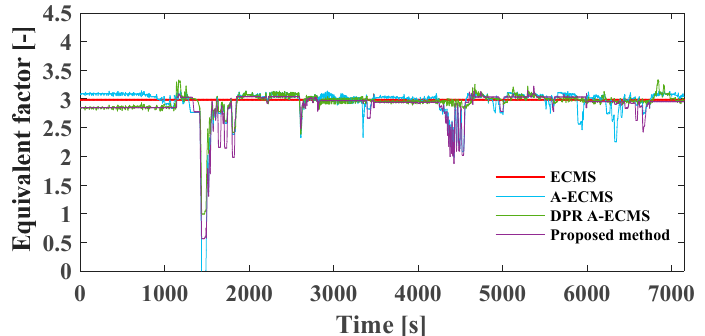
Figure 12. Comparison of the equivalent factors.